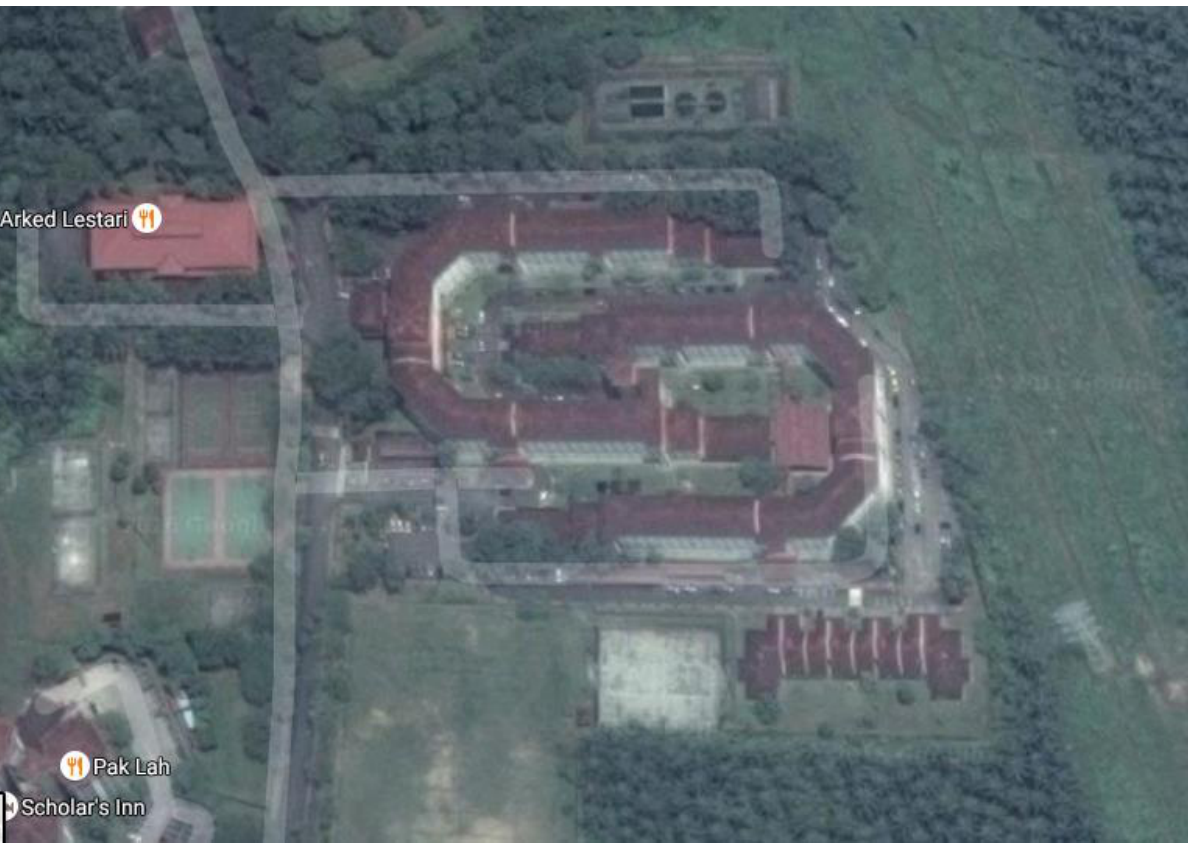
Figure 1. Kolej 9, UTM, Skudai (The test